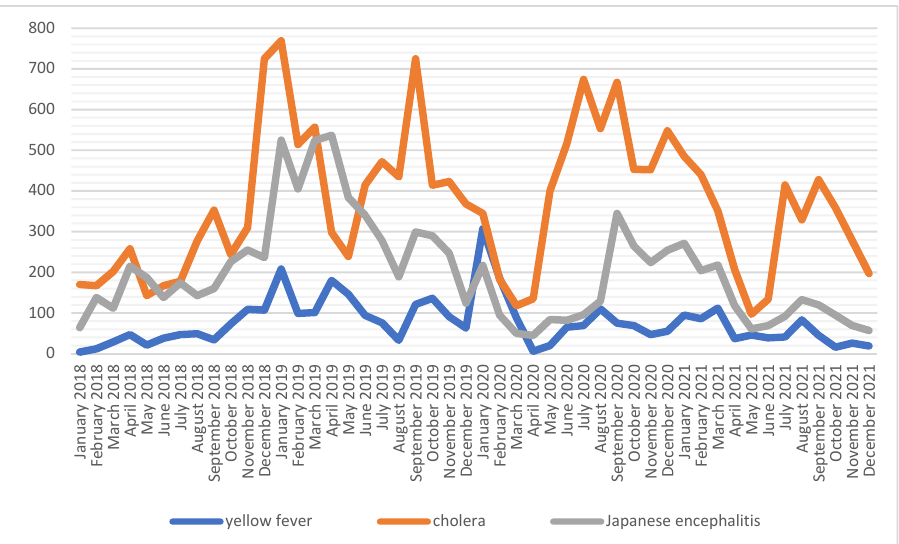
Figure 6. Number of vaccinations against yellow fever, cholera and Japanese encephalitis among soldiers in 2018–2021.